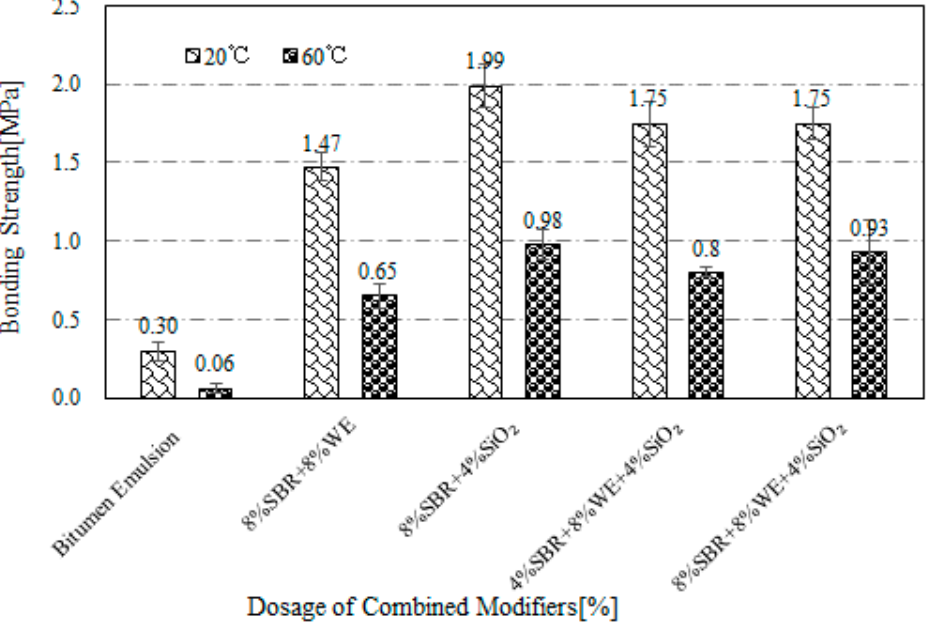
Figure 6. Bonding strength of SBR + WE + SiO 2 -modified bitumen emulsion.